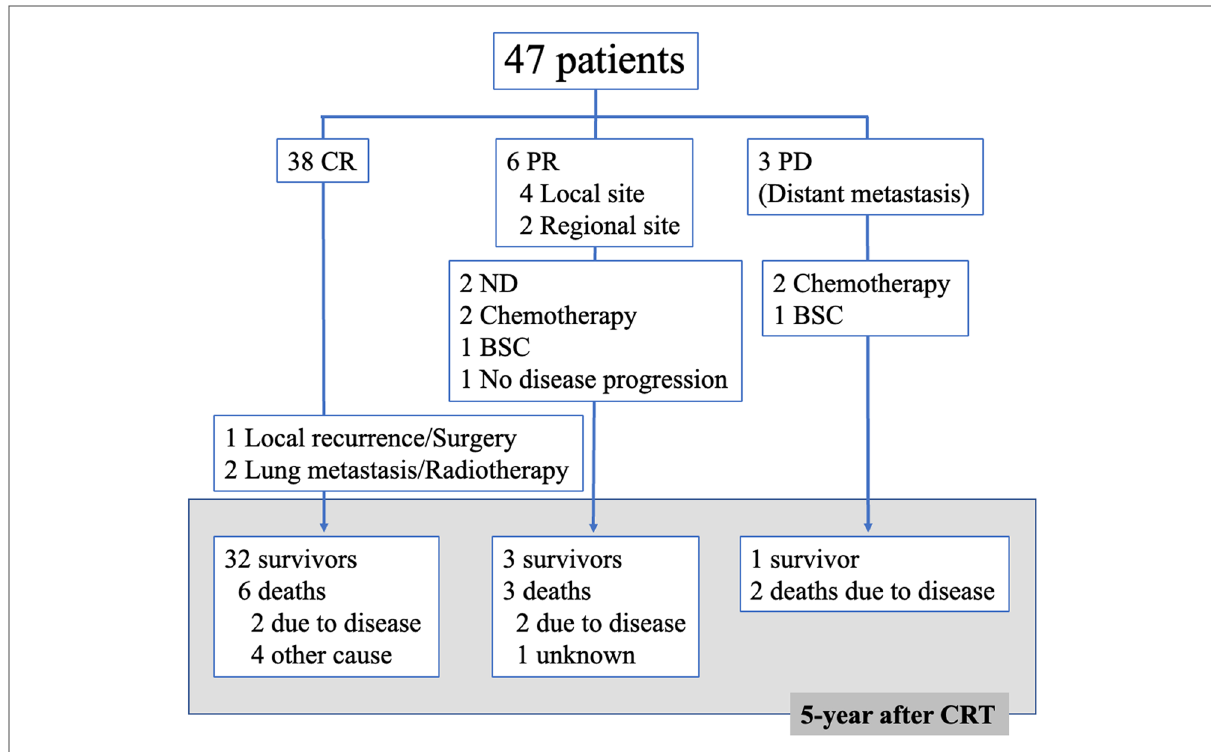
FIGURE 1 Flow diagram of 47 patients after concomitant chemoradiotherapy (CRT) CR, complete response; PR, partial response; PD, progressive disease; ND, neck dissection; BSC, best supportive